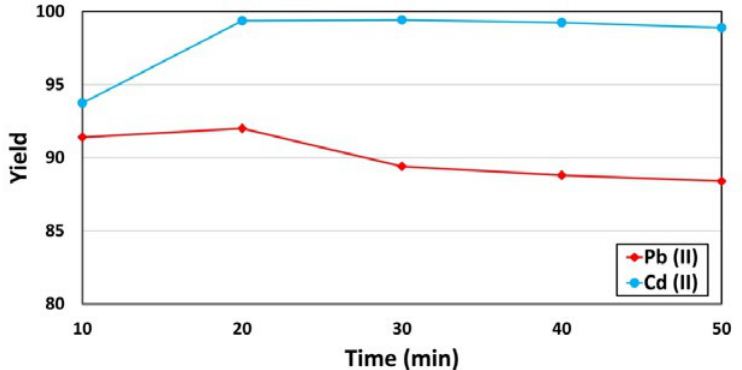
Fig. 7. Effect of contact time on the removal of Pb 2+ and Cd 2+ ions